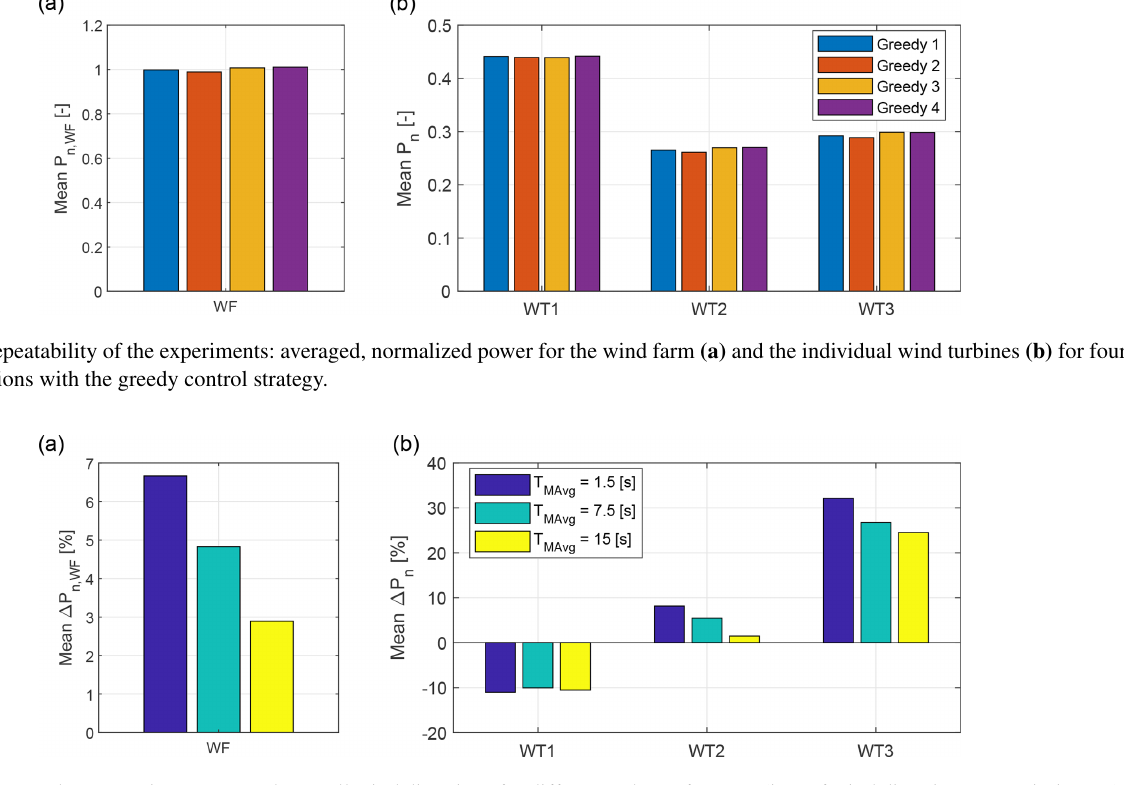
Figure 12. Averaged power gains aggregated over all wind directions for different values of T MAvg (i.e., of wind direction uncertainties σ (cid:56)